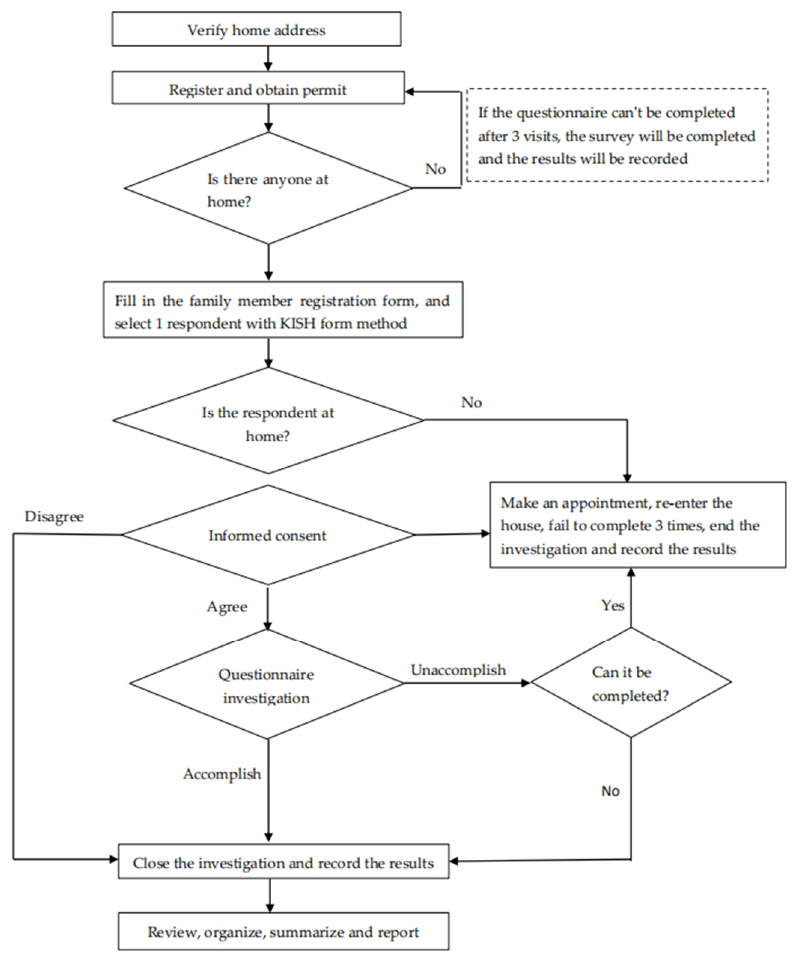
Figure 2. Flow chart for household investigation in the study on health literacy in a 15 to 69-year-old population, Henan, China, 2016. Kish grid-based sampling within each household.